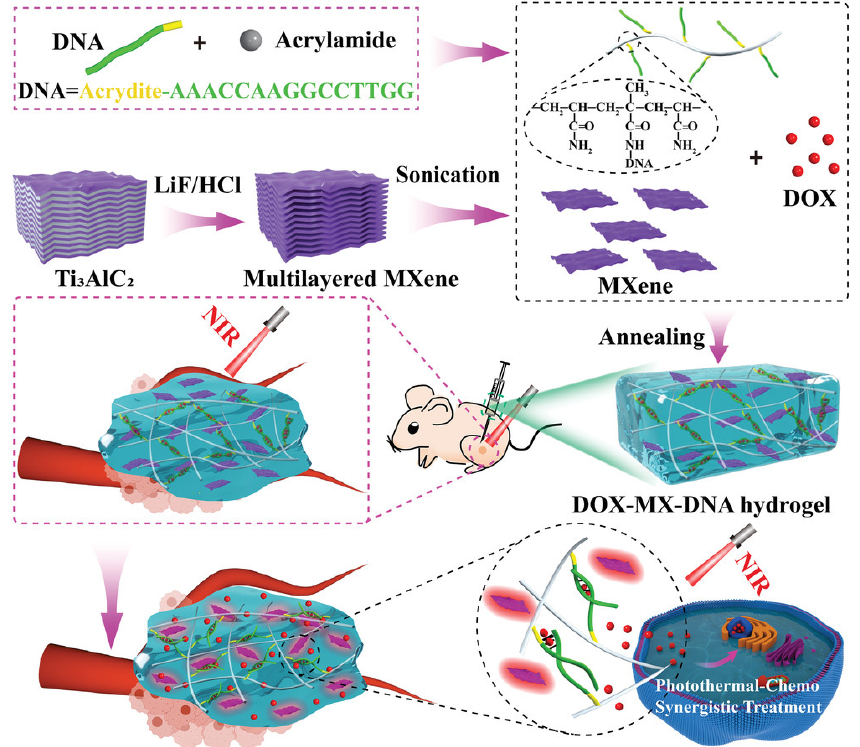
Figure 8. Schematic illustrations of self-assembled injectable hydrogels for combinational antitumor PDT-chemotherapy. Reprinted with permission from [229].